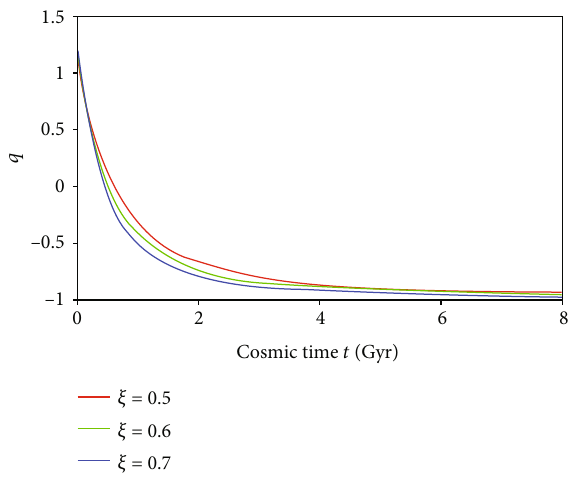
Figure 4: Plot of EoS parameter versus cosmic time t for ε = − 0 : 33, − 0 : 67, − 0 : 9 , ξ = 0 : 6 , l = 0 : 6 , b = 0 : 5 , and ρ